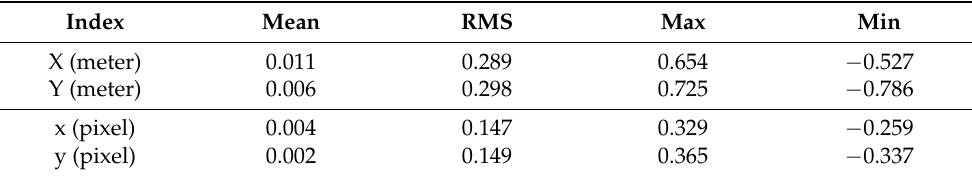
Table 14. Positioning accuracy of the corresponding image points after geometric calibration.